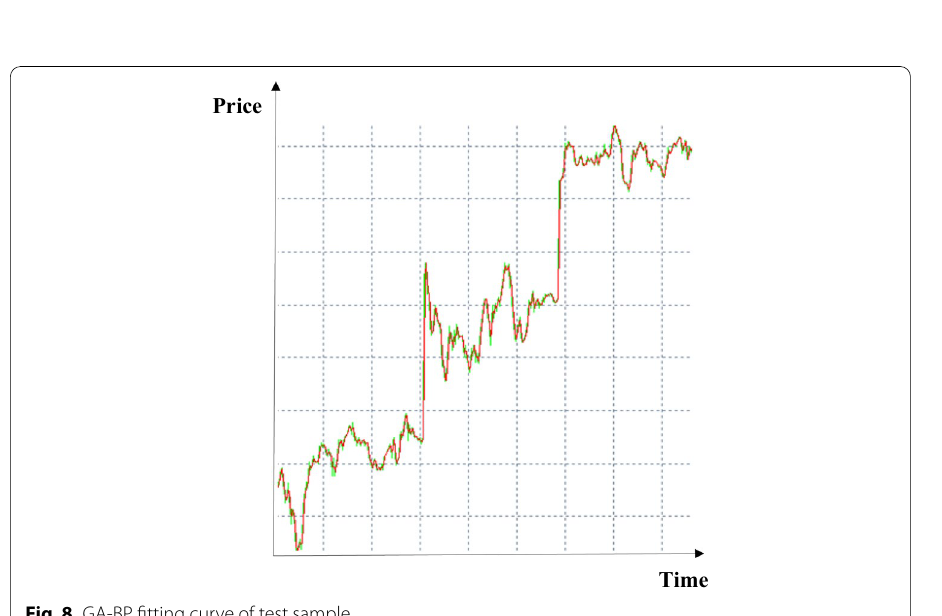
Fig. 8 GA-BP fitting curve of test